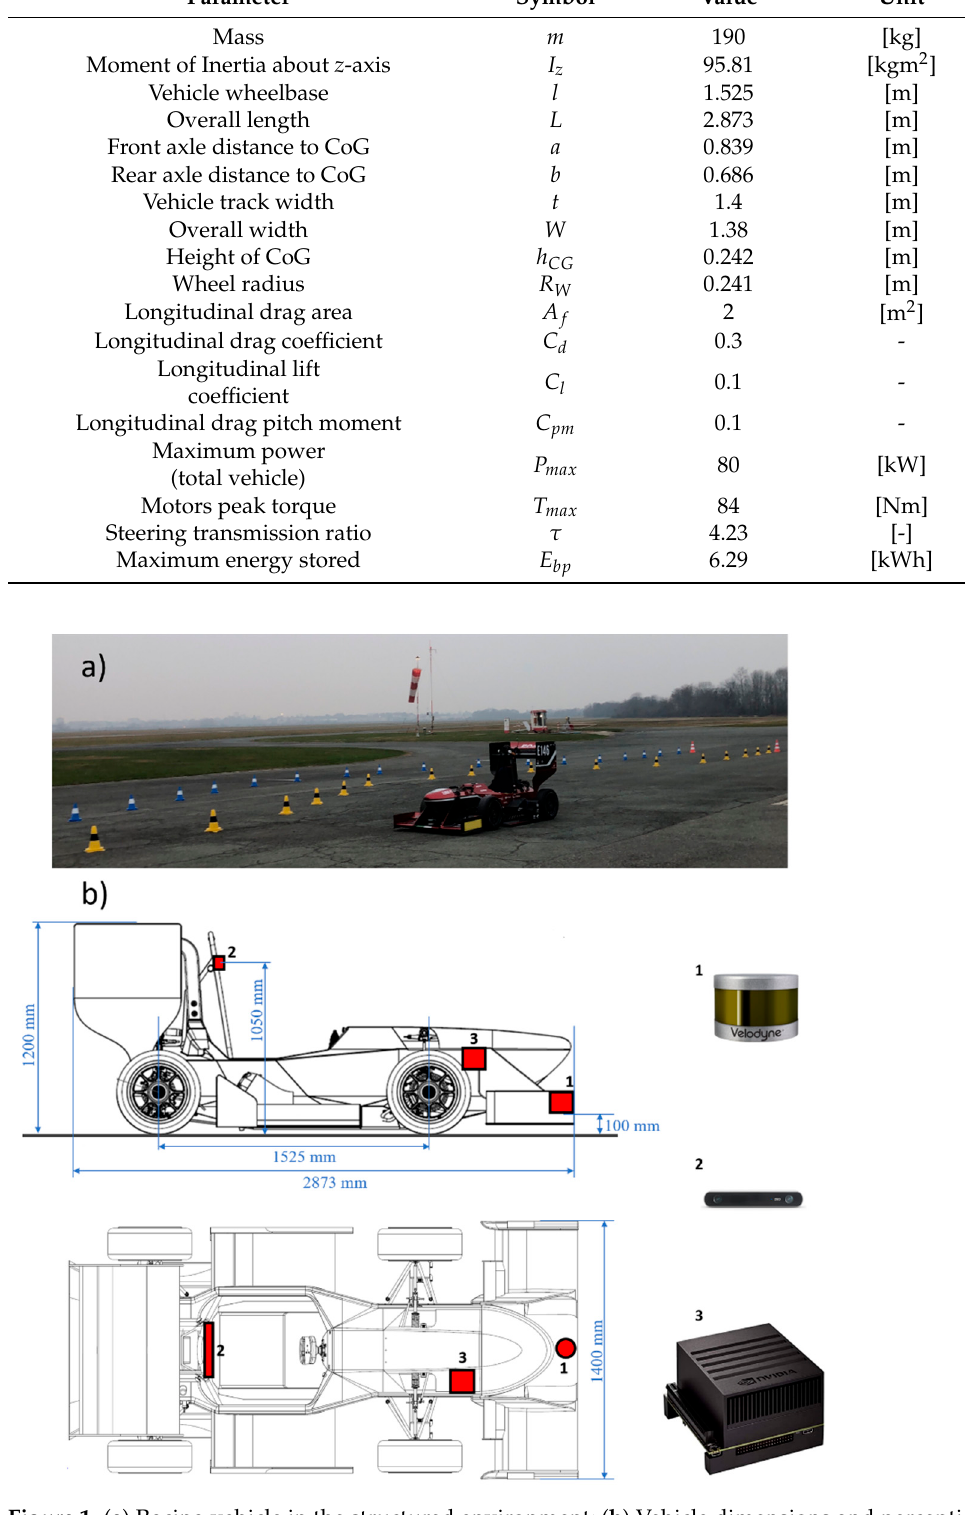
Figure 1. ( a ) Racing vehicle in the structured environment; ( b ) Vehicle dimensions and perception hardware location: 1. Velodyne VLP-16 LiDAR; 2. Stereolabs ZED stereocamera; 3. nVIDIA Jetson Xavier high-performance computational unit with embedded GPU.